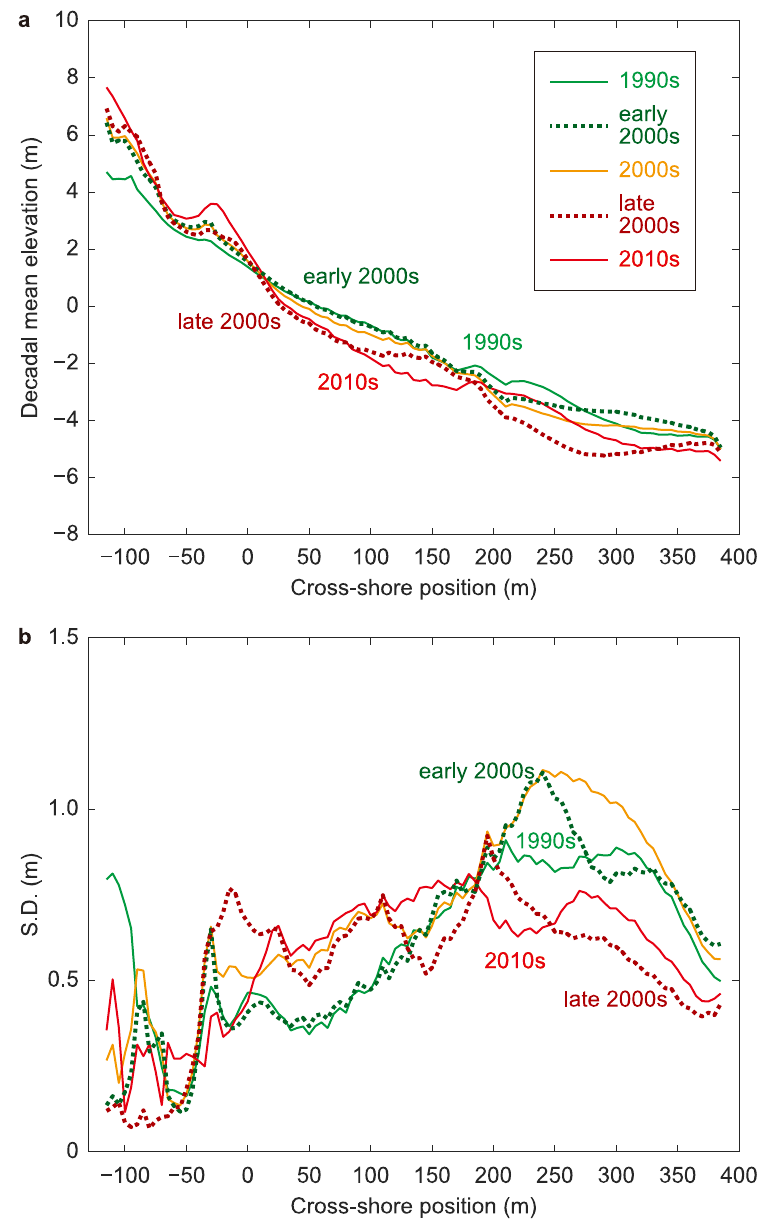
Figure 8. Comparison between the early and late 2000s. ( a ) Decadal mean profiles in the early and late 2000s divided from that of the mean profile in the 2000s; ( b ) standard deviations of the elevations corresponding to ( a ).